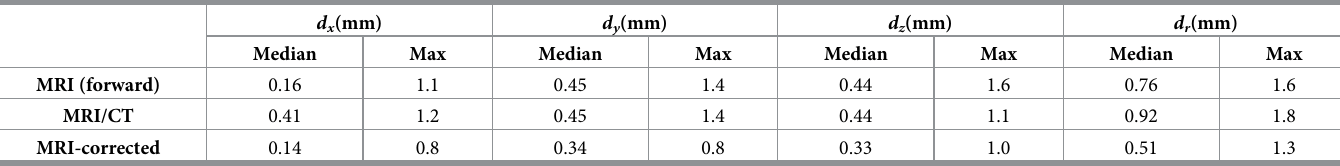
|, for all 26 control points considered in this study. The MRI DICOM coordinate system is i